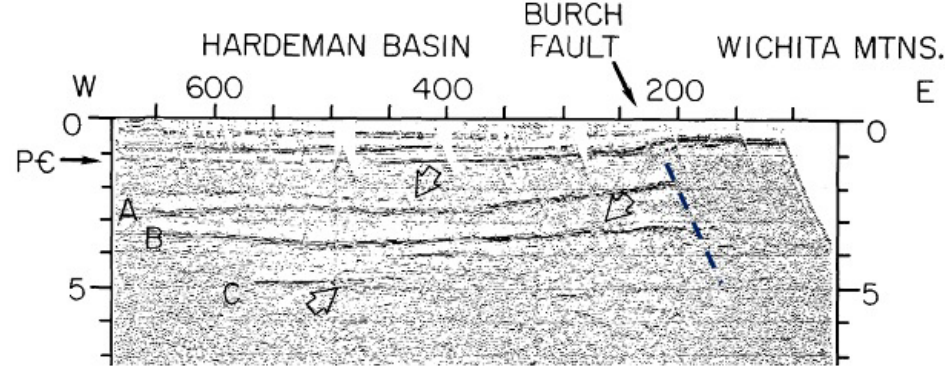
Figure 8. Layered reflectors traced by COCORP seismic profiles in northern Texas and southern Oklahoma [66]. P-C indicates the top of Precambrian basement from local boreholes. Arrows mark the reflective sequence (A, B, and C), here interpreted as mafic sills. Dashed line indicates the apparent truncation of basement reflections along the Burch fault of the Wichita Mountains.